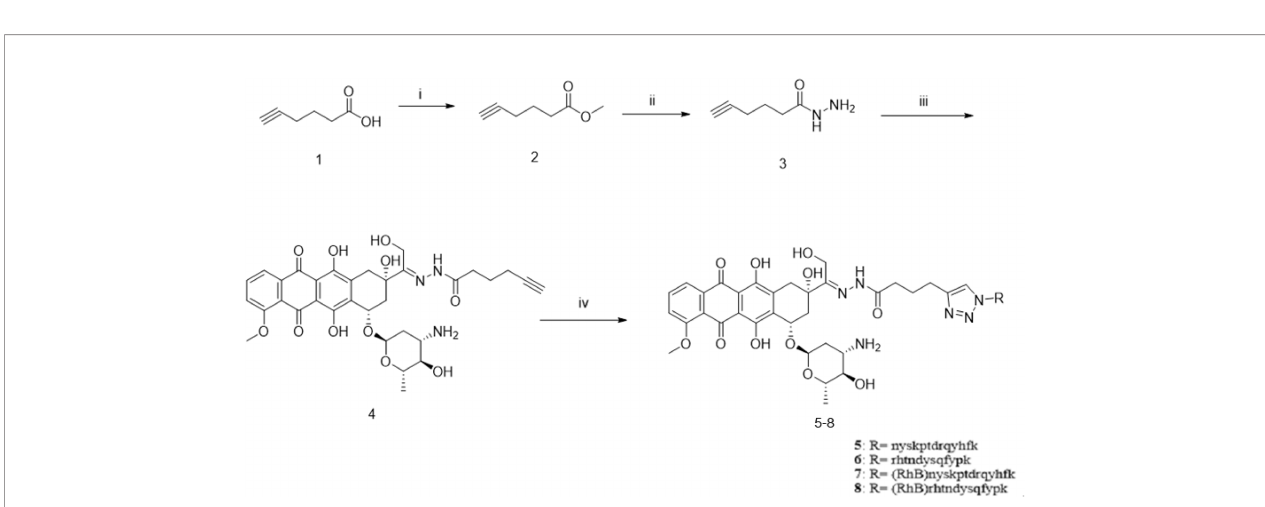
FIGURE 2 | The synthesis of PPA1-DOX conjugate with an acid-labile linker. Reagents and conditions: (i) MeOH, DCC, DMAP, r.t., 4h; (ii) NH 2 -NH 2 80% in H 2 O, EtOH, 80°C, 6h; (iii) doxoriubicin, TFA, MeOH, 4A molecular sieves, r.t., 24h, (iv) nyskptdrqyhf-Lys(N 3 ), CuSO 4 .5H 2 O, sodium ascorbate, TBTA, DMF/H 2 O, r.t., 4h, N 2